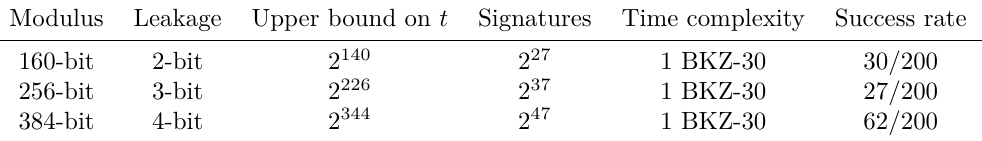
Table 6: Utilizing more data to improve lattice